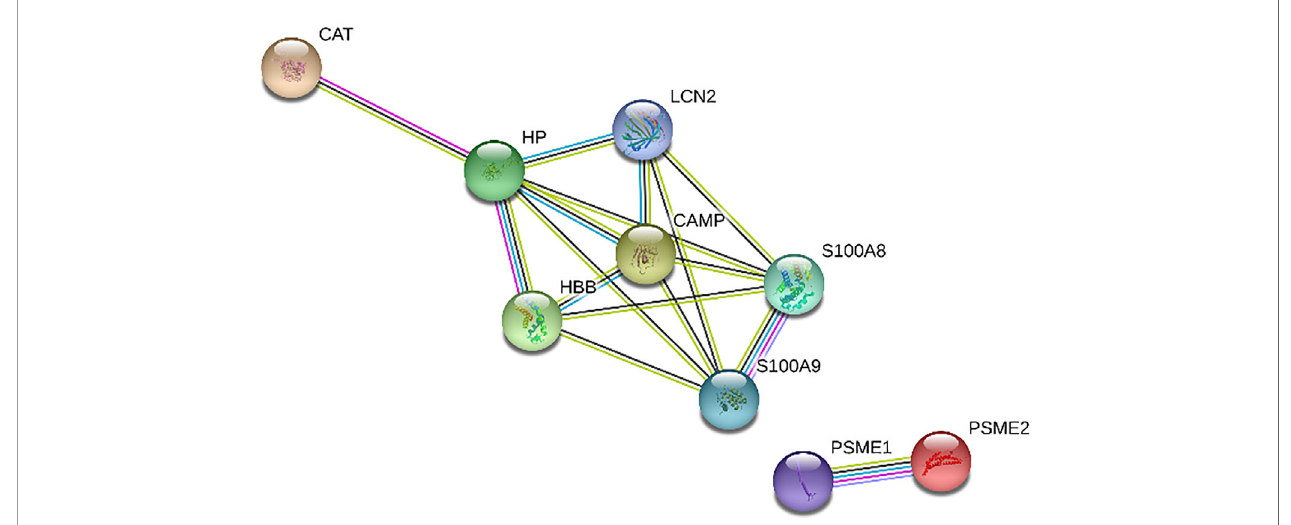
FIGURE 2 | Protein-protein interaction network in MM-MC CD138-CD105- vs. HD-MC CD138-CD105- : downregulated proteins. Nodes represent proteins and edges represent protein-protein associations. Node color: colored nodes and white nodes represent, respectively, query proteins and fi rst shell of interactions, and second shell of interactions. Node content: empty and fi lled nodes represent, respectively proteins of unknown 3D structure, and some 3D structure is known or predicted. The edges are composed of known interactions, predicted interactions, among other forms of interaction, including co-expression. (STRING